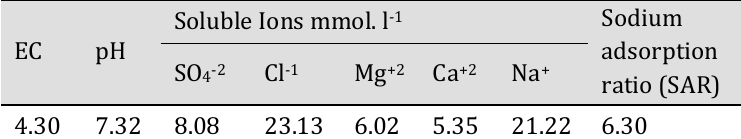
Table 2. Properties of well water used in